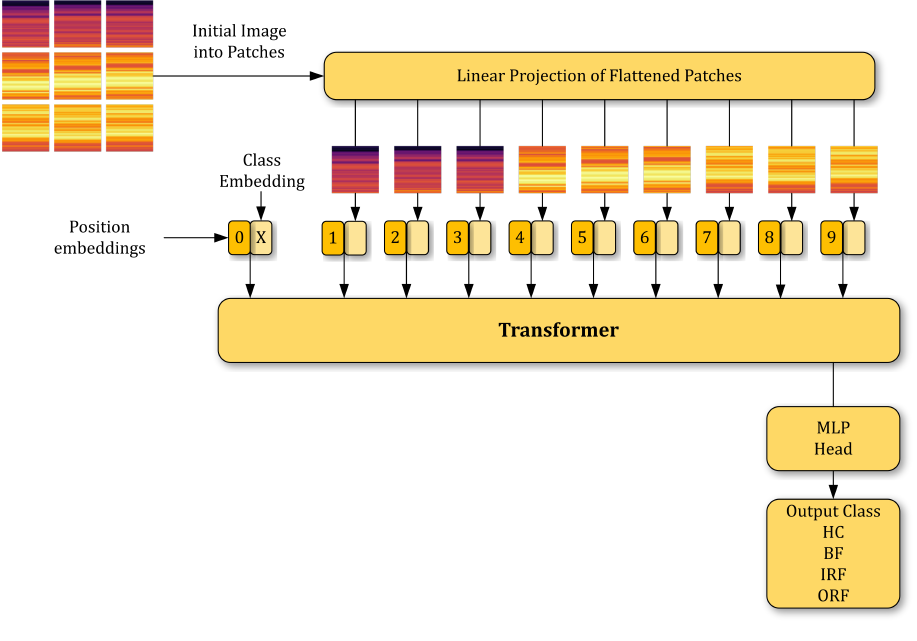
Figure 7. Block diagram of the overall